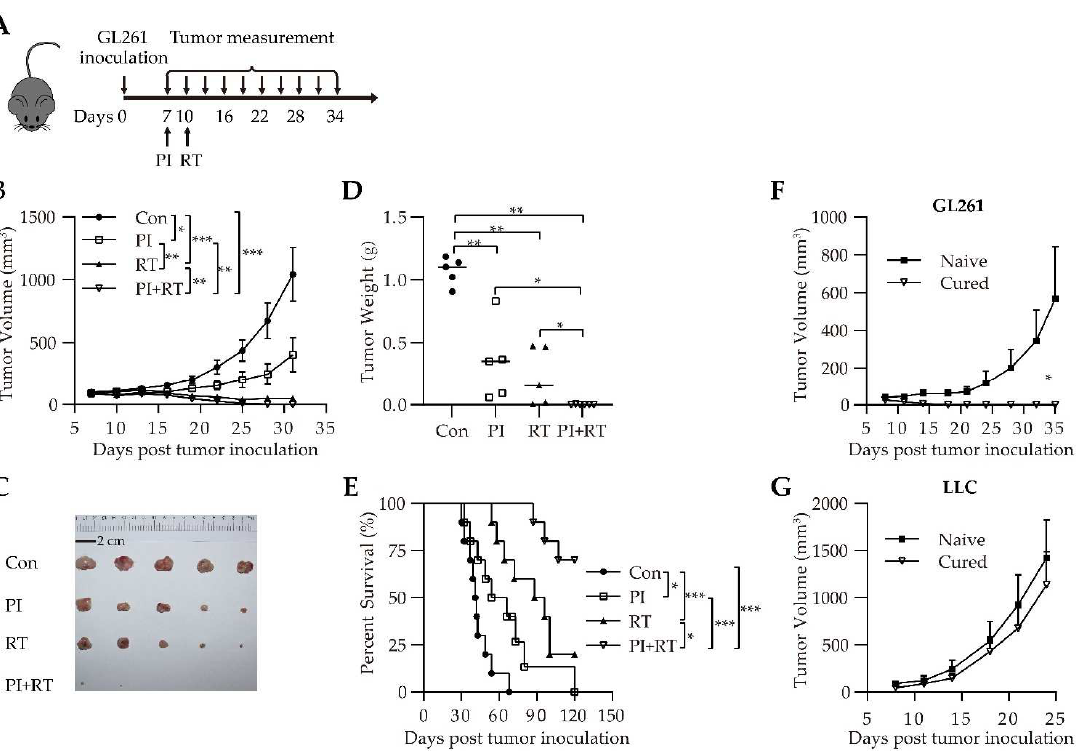
Figure 2. Therapeutic efficacy of PI in combination with RT in subcutaneous GL261 tumor model. ( A ) Schematic representation of combination therapy in subcutaneous GL261 tumor-bearing mice. ( B ) Tumor growth curves ( n = 10 per group). At the endpoint, the statistical differences between groups were analyzed with an unpaired two-tailed Student’s t-test. ( C ) Tumor sizes and ( D ) weight of the s.c. tumor mass on day 29 after tumor cell inoculation ( n = 5). The statistical differences be-